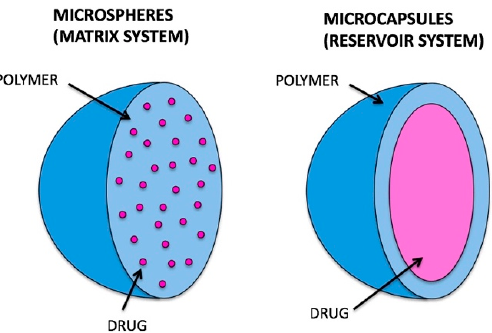
Figure 5. Photograph of magnetic microsphere particles suspended in water and under the presence of an externally placed magnet. Reprinted with permission from [39].